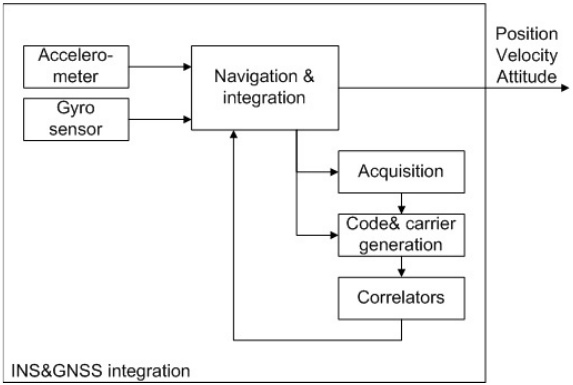
Figure 3. INS/GNSS deeply coupled integration scheme.